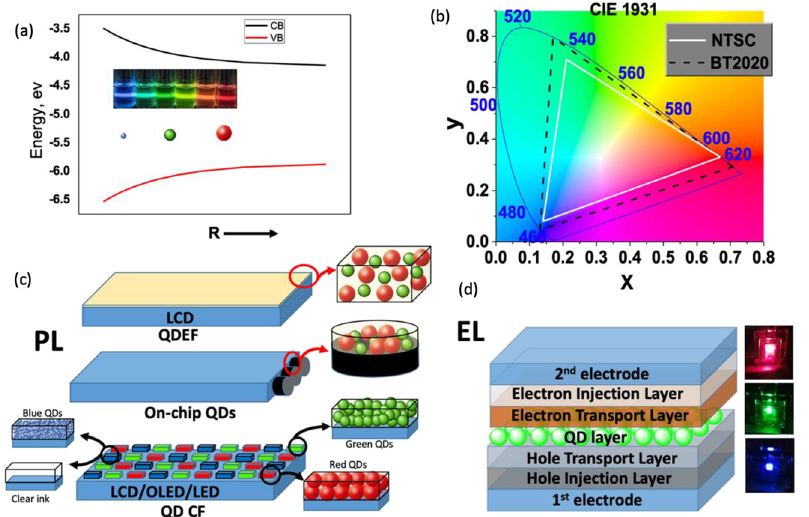
Figure 1: (a) Simple illustration of the energy level dependence for the quantum dots on the particle size. (b) The color gamut achievedbyquantumdots(QD)withnarrow emission bandwidth. The nanoparticle offers a very large coverage of human vision. (c) Shows the three most common device architecture used for the display devicein photo luminescence nanoparticle. (d) Shows the simple device structure for the electro-luminescence device and inset show the photographs of the few mono- chromatic